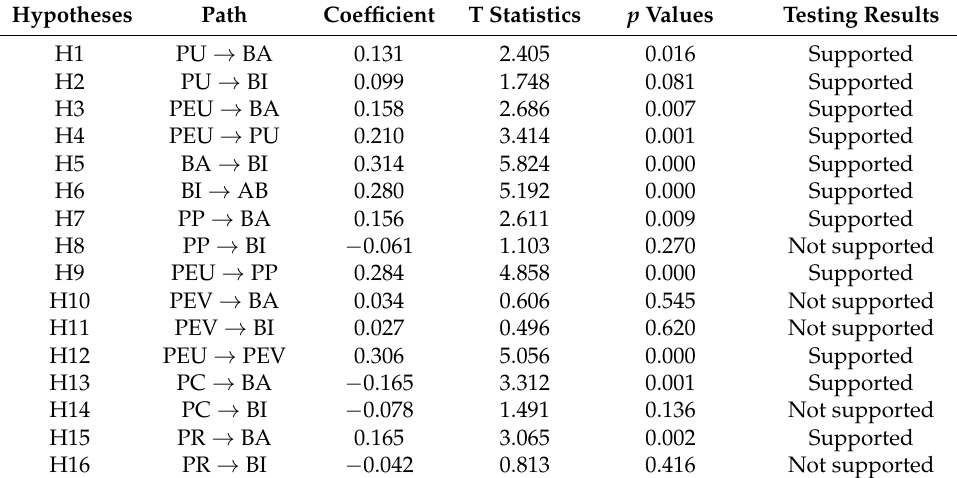
Table 9. Hypotheses testing results.